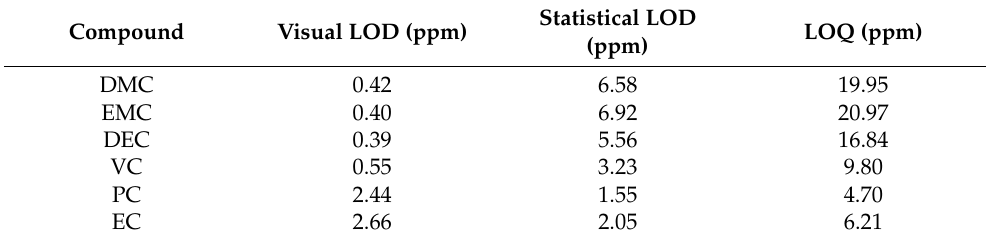
Table 6. Limit of detection (LOD) and limit of quantification (LOQ) for DMC, EMC, DEC, VC, PC, and EC obtained using the GC × GC/EI TOF MS